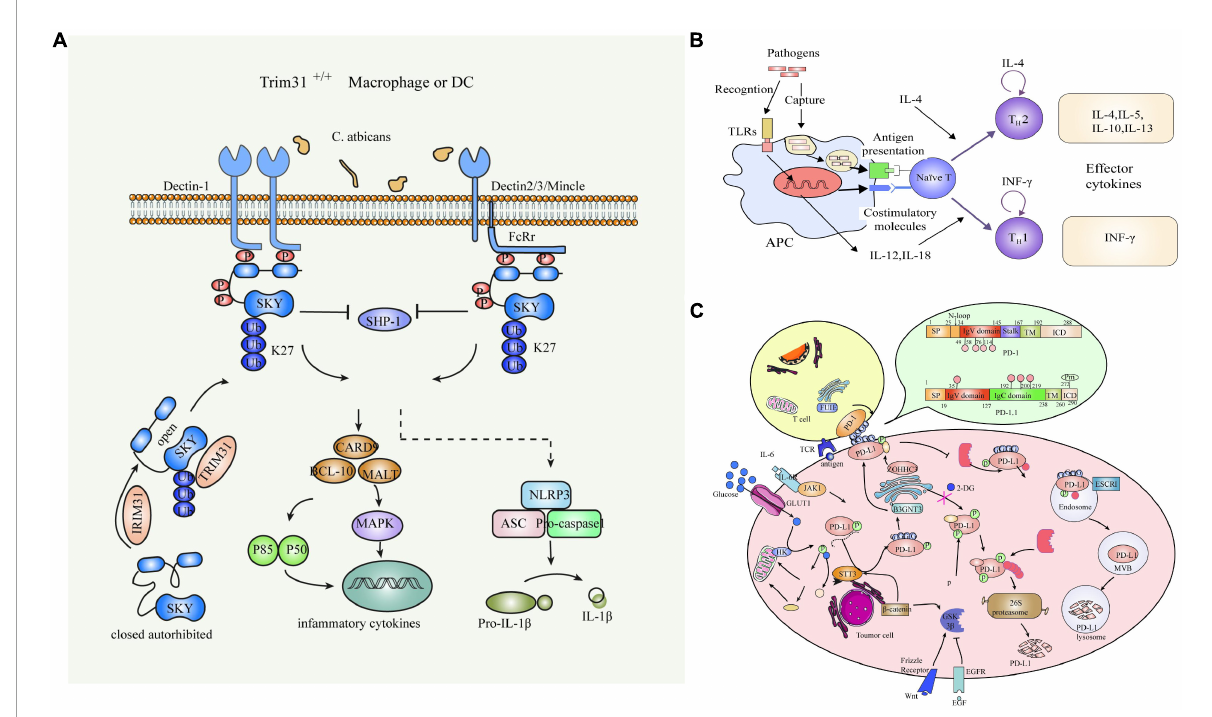
FIGURE2 Common PRRs of C. albicans interacting with Macrophages. (A) Schematic diagram of the C-type lectin receptor. (B) Toll-like receptors. (C) NOD-like